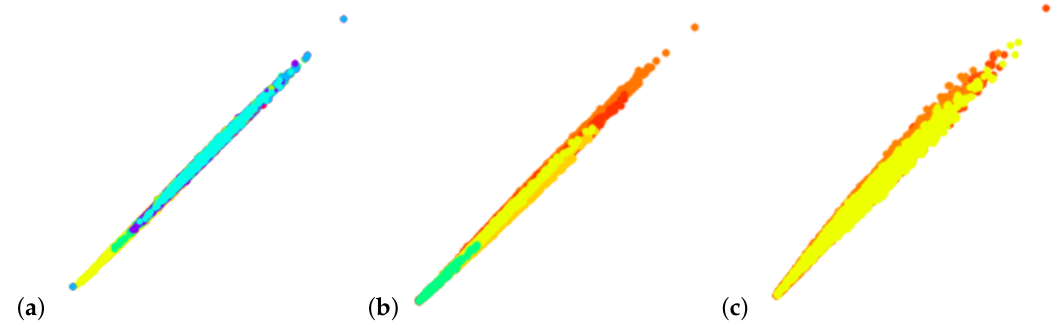
Figure 20. PCA for linear embeddings does not allow for observing/separating clusters: ( a ) Mouse cerebellum in negative ion mode, ( b ) mouse cerebellum in positive ion mode, and ( c ) rat testis data sets